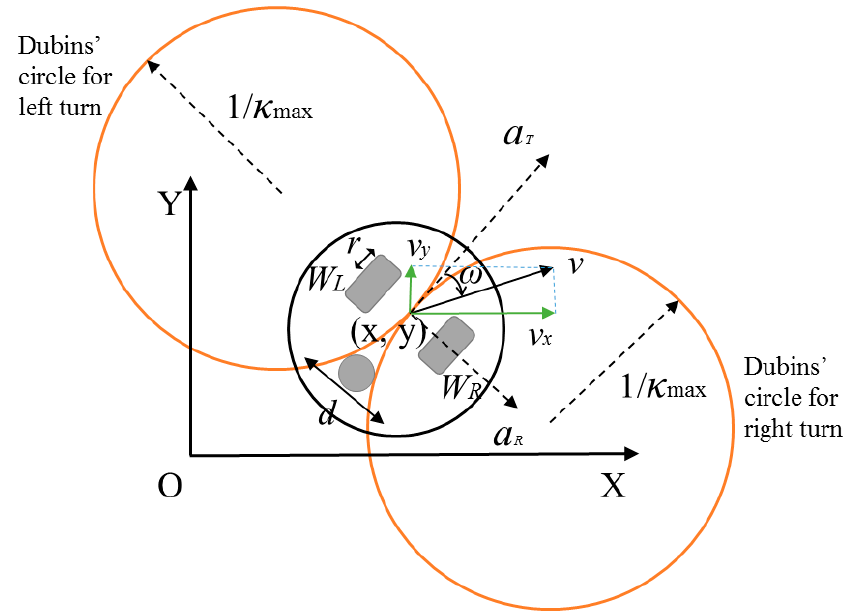
Figure 2. The mobile robot’s kinematic model with the curvature constraint, where a positive curvature denotes a right (clockwise) turn. The robot is assumed as a circle. The robot velocity U and its x -component v x , y -component v y , the radial acceleration a R , and tangential acceleration a T , are shown. The O-XY coordinate system is the global coordinate frame and a local frame is attached to a representative point (the center) of the circular mobile robot.